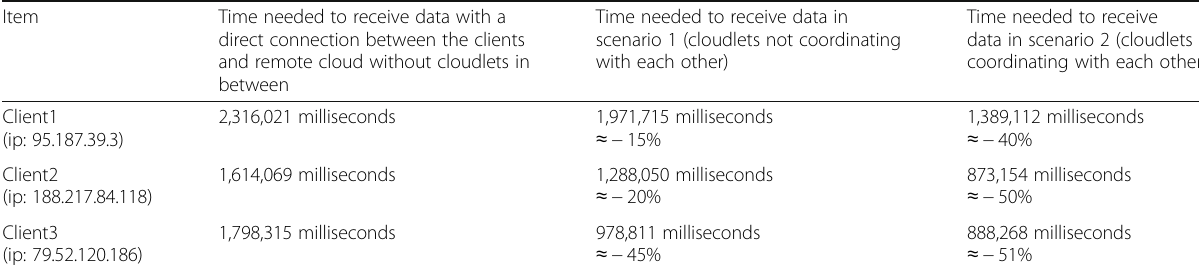
Table 4 Summary of the Experimental